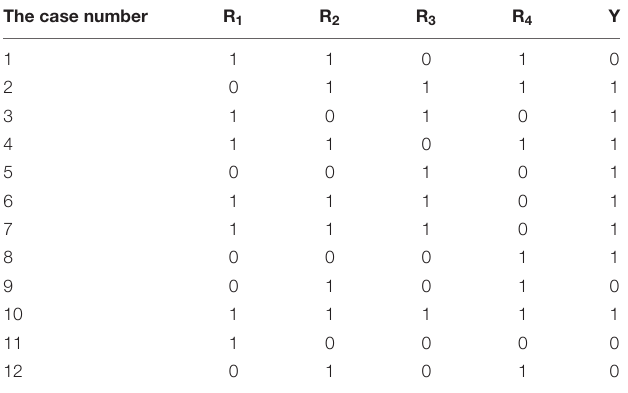
TABLE 3 | Table of truth.